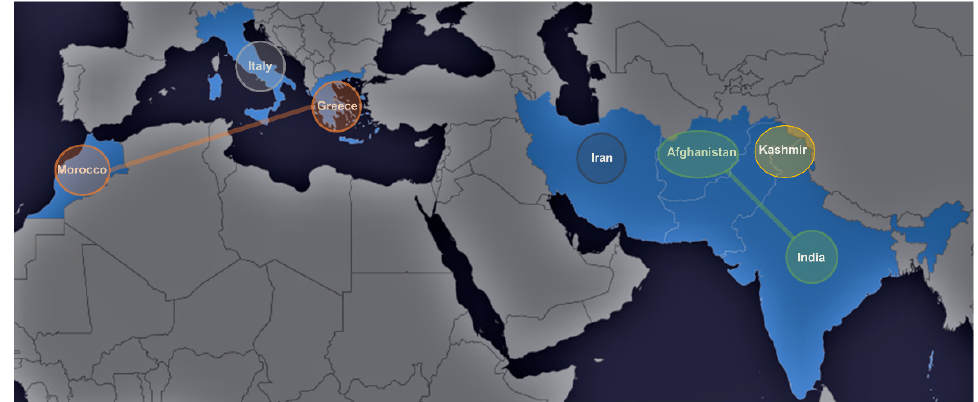
Figure 2. Regions of collected specimens of saffron samples along with their associated cluster.